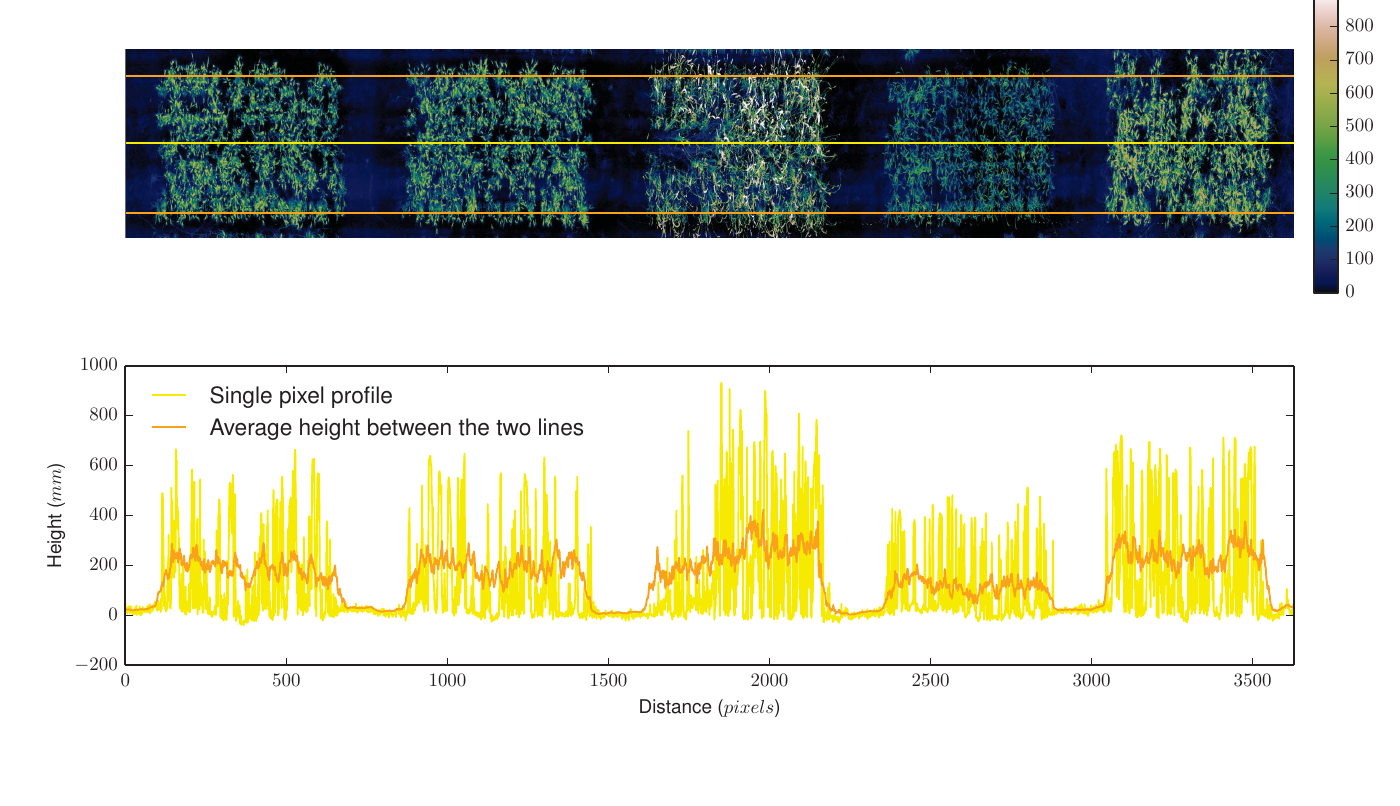
Figure 4. Profile of the LiDAR elevation. The yellow line in the graph represents the profile of the single-pixel width transect across the plots, denoted in yellow in the image; while the orange line in the graph represents the average height of all the pixels between the two orange lines in the